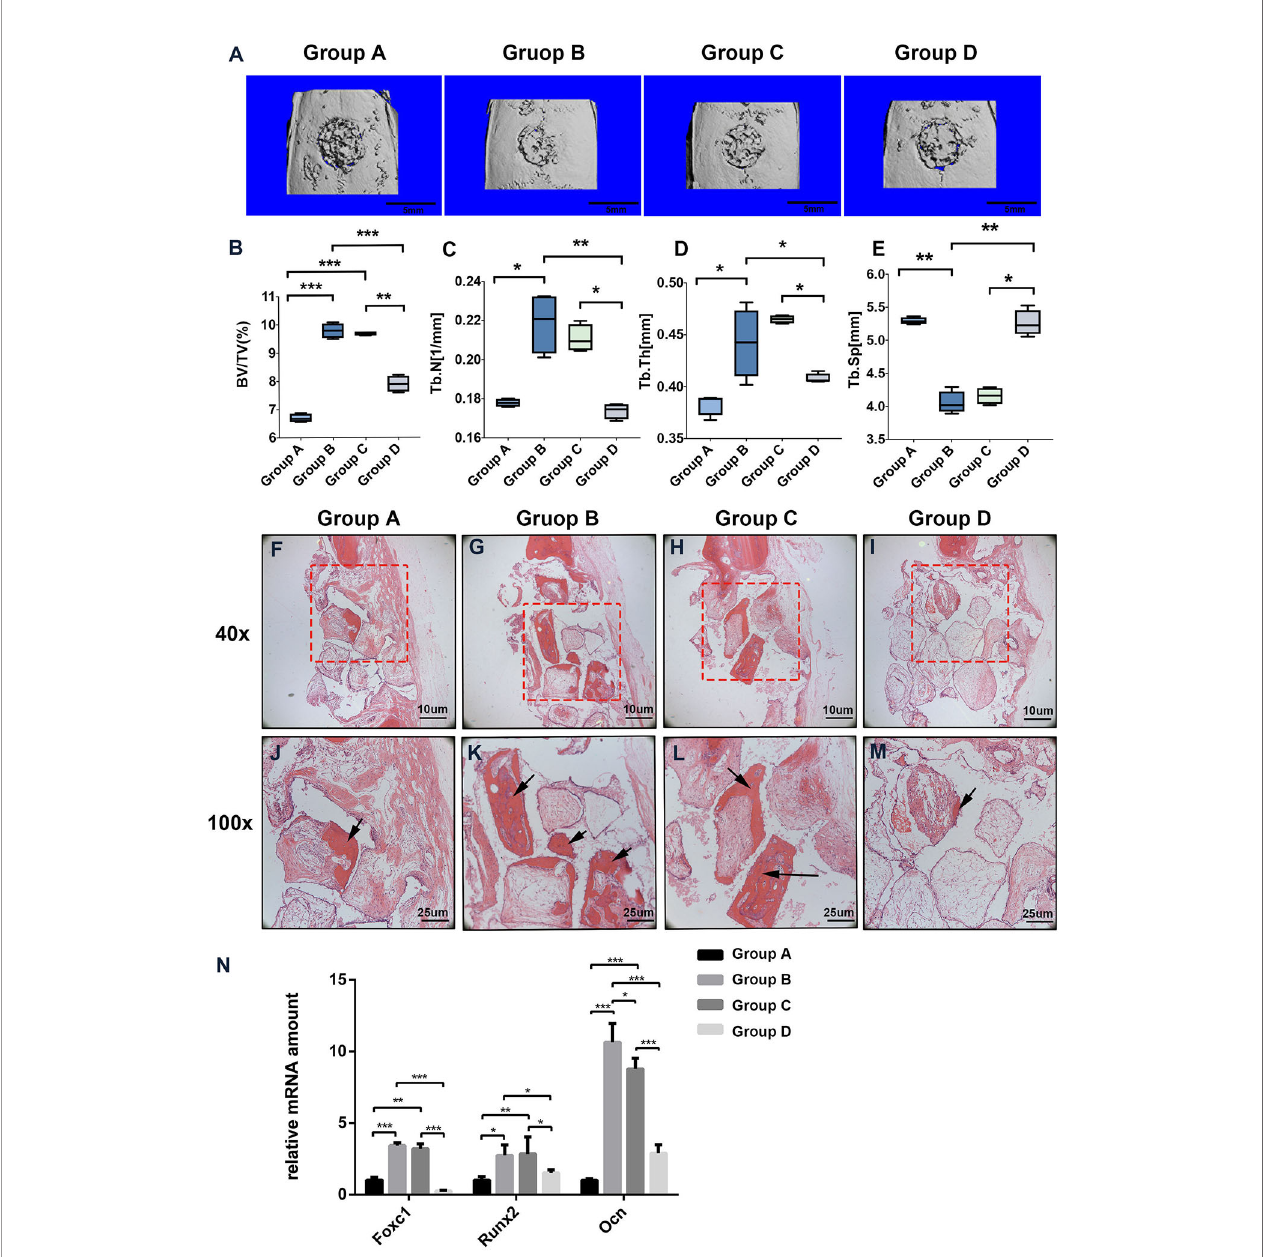
FIGURE 5 | Foxc1 stimulates osteogenic differentiation induced by intermittent PTH treatment in vivo. (A) Three-dimensional reconstruction images of the defect sites by micro-CT in different groups at 8 weeks. (B – E) BV percentage (B) , trabecular number (C) , trabecular thickness (D) , and the number of trabecular (E) in different groups were quanti fi ed. (F – M) H&E staining of the defect sites in different groups at 8 weeks. (N) mRNA expression levels of Foxc1, Runx2, and Ocn in different groups at 8 weeks. Scale bar = 5 mm in (A) , Scale bar = 10 m m in (F – I) , Scale bar = 25 m m in (J – M) . (J – M) are local ampli fi cation of boxed area in (F – I) , respectively. Arrow indicates new bone formation. * p < 0.05, ** p < 0.01, *** p <